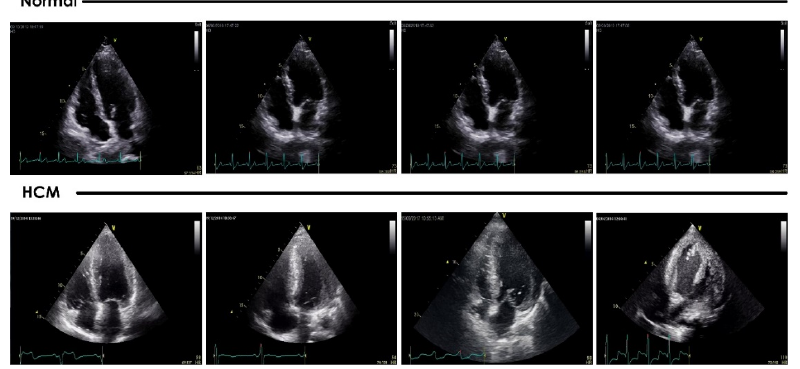
Figure 2. Example apical 4-chamber US images of normal versus hypertrophic cardiomyopathy par- ticipants.